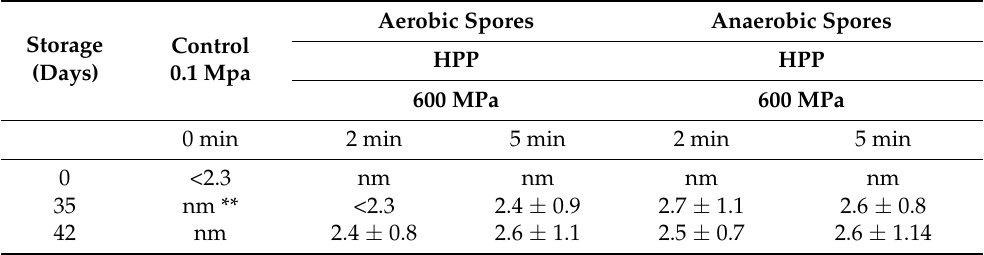
Table 2. Microbial counts (total viable count (log cfu/g)) * for aerobic (A) and anaerobic (B) spores in cauliflower before (control) and after HPP. The samples were stored for up to 42 days in cold storage (4 ◦ C). Aerobic Spores Anaerobic Spores Storage Control HPP (Days) 0.1 Mpa